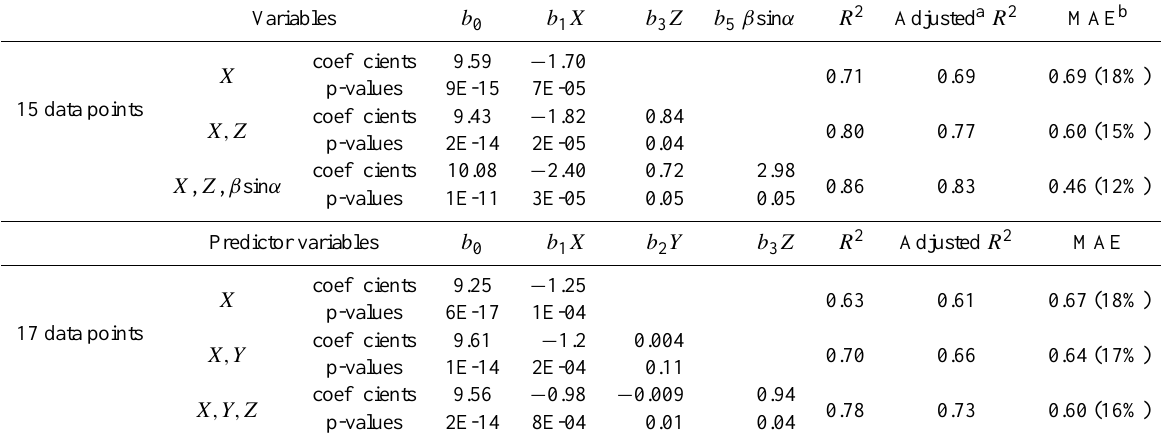
Table 3. Regression results of log D with selected variables ( X , Y , and Z values are in a unit of km) for 15 and 17 points, respectively.